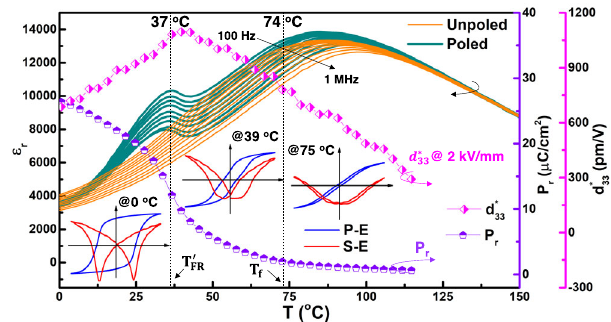
Fig. 1 | Temperature-dependent on dielectric and ferroelectric properties of PL 8.3 Z 66 T 34 . The evolution of dielectric permittivity of both unpoled and poled samples, P r , and large electromechanical response d 33 * (@ 2kVmm − 1 ) depending on temperature. The insets are the P-E and S-E curves at various